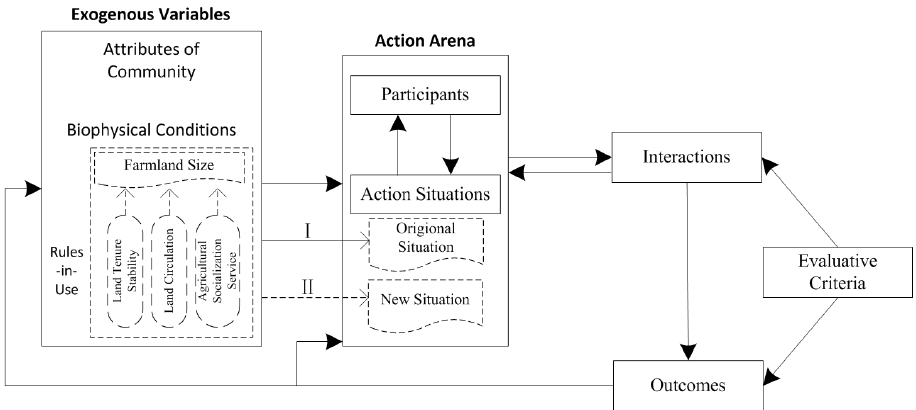
Figure 2. Framework for analyzing the relationship between farmland scale management and irrigation collective action.